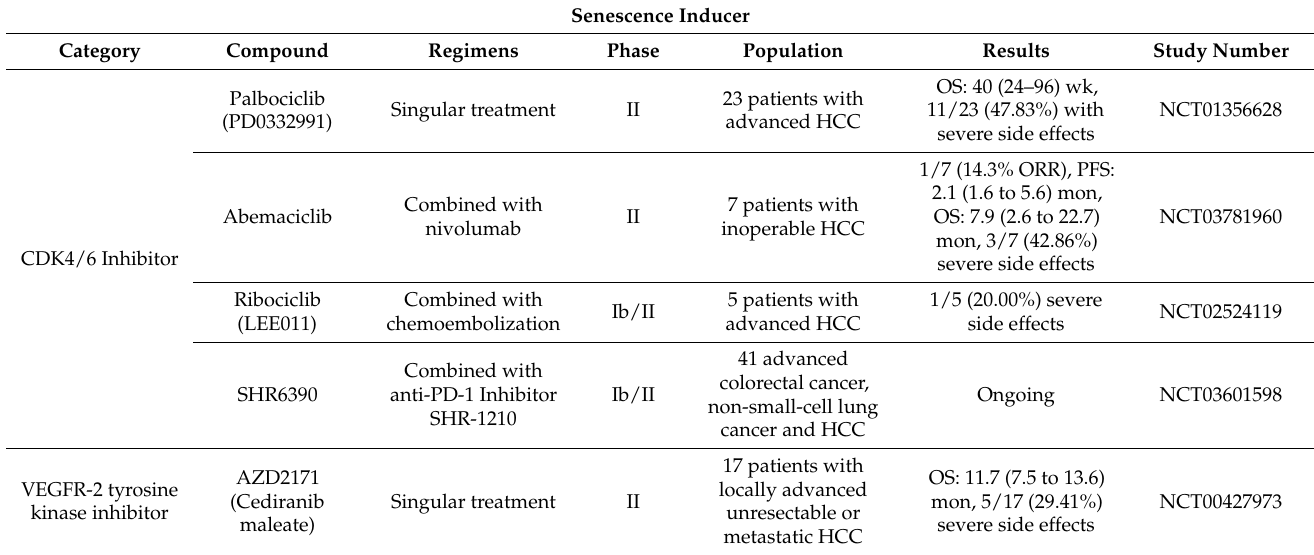
Table 1. Senescence-targeting therapies in clinical